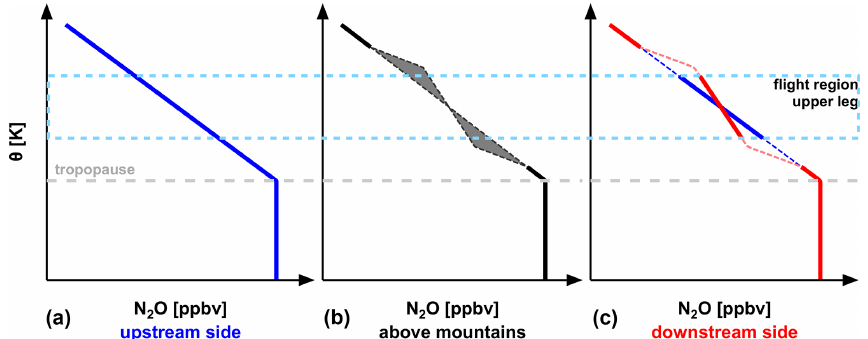
Figure 7. Schematic evolution of potential temperature (cid:50) versus N 2 O in the presence of cross-isentropic mixing at the tropopause (e.g., by orographic-wave-induced turbulence). The blue curve (a) shows the situation on the upstream side. The relation between N 2 O and (cid:50) (blue) is modified by mixing ( b ; dotted black and shaded gray) over the mountains leading to a modified profile on the downstream side ( c ; red) compared to the original upstream relation (blue). The dashed gray line shows the tropopause and the dashed light blue rectangle the flight region of the upper leg.